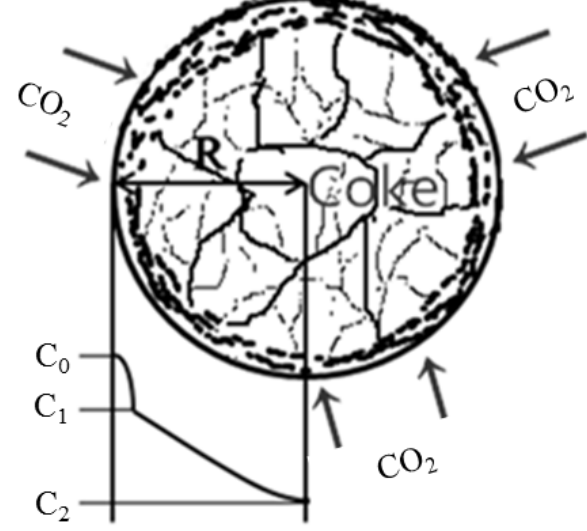
(C 0 , C 1 and C 2 indicate the gas concentration of CO 2 in different radial position, C 0 >C 1 >C 2 ) Figure 4: Gasification reaction model of coke blocks attached the unburnt pulverized coal